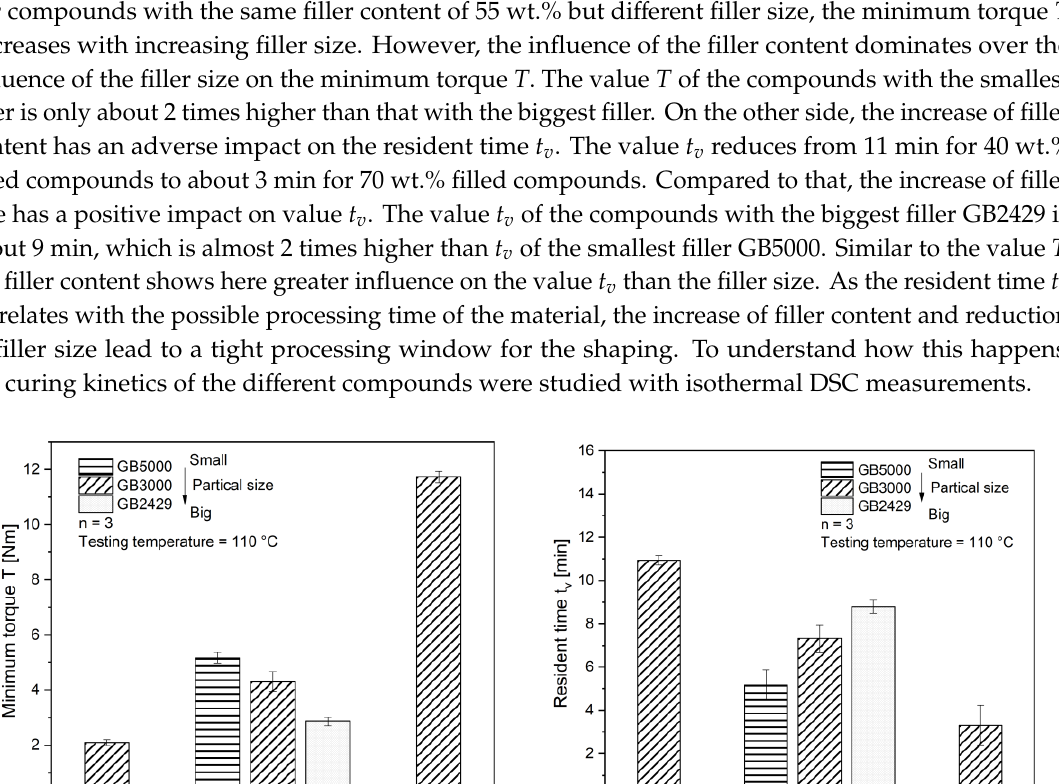
Figure6. ( a )Volume-baseddiameterdistributionofglassbeads(GB)at10 µ mbandwidth( b )Cumulative Figure 6. ( a ) Volume-based diameter distribution of glass beads (GB) at 10 µm bandwidth ( b ) volume content of GBs based on their diameter. Cumulative volume content of GBs based on their diameter. Table 3. Summary of the particle distribution of used GBs.